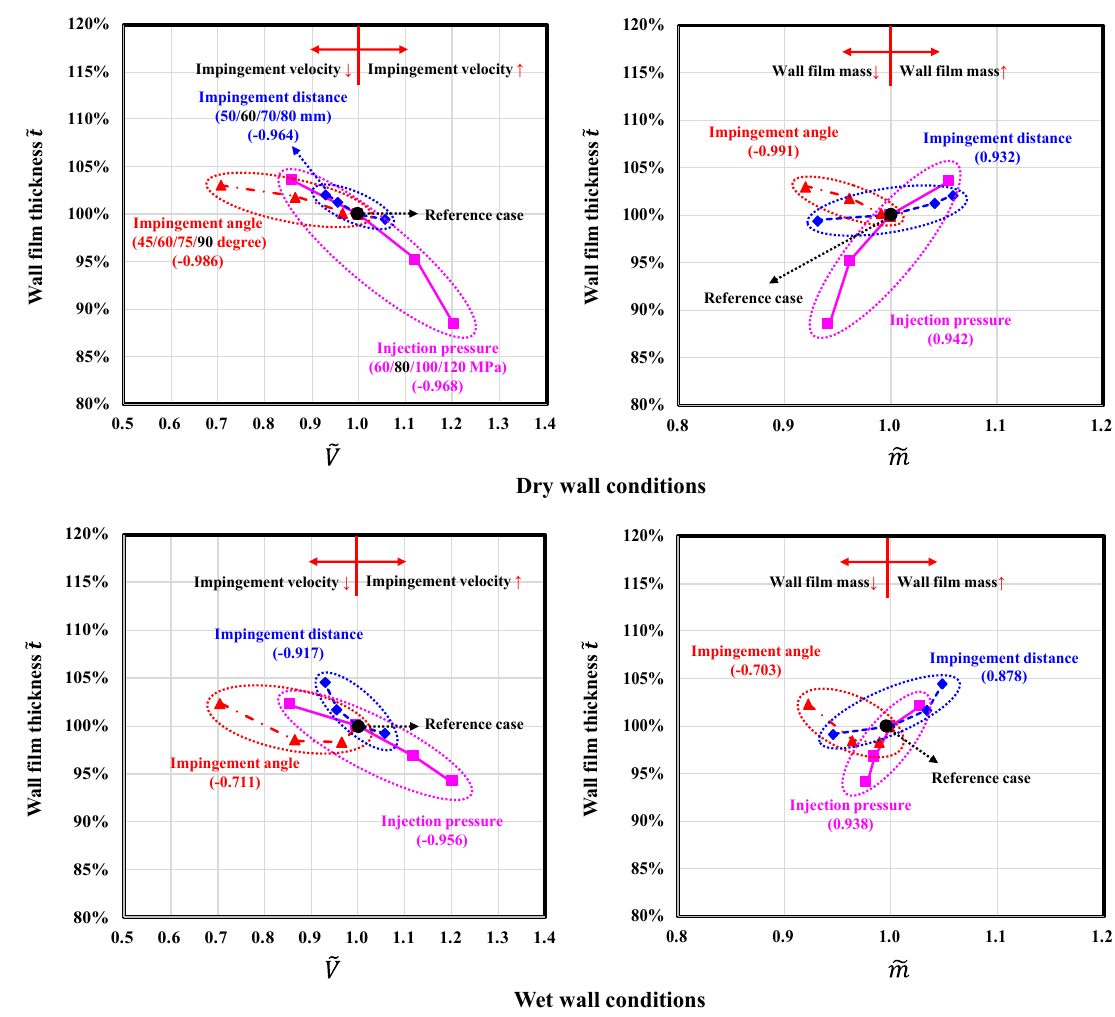
Figure 12. Relationships between wall film average thickness and dimensionless number (cid:101) V and (cid:101) m . Increasing the injection pressure increased the impingement momentum while decreased the wall film mass, which both had the effect on reducing the wall film average thickness under dry wall and wet wall conditions. The impact factors of impingement momentum and wall film mass